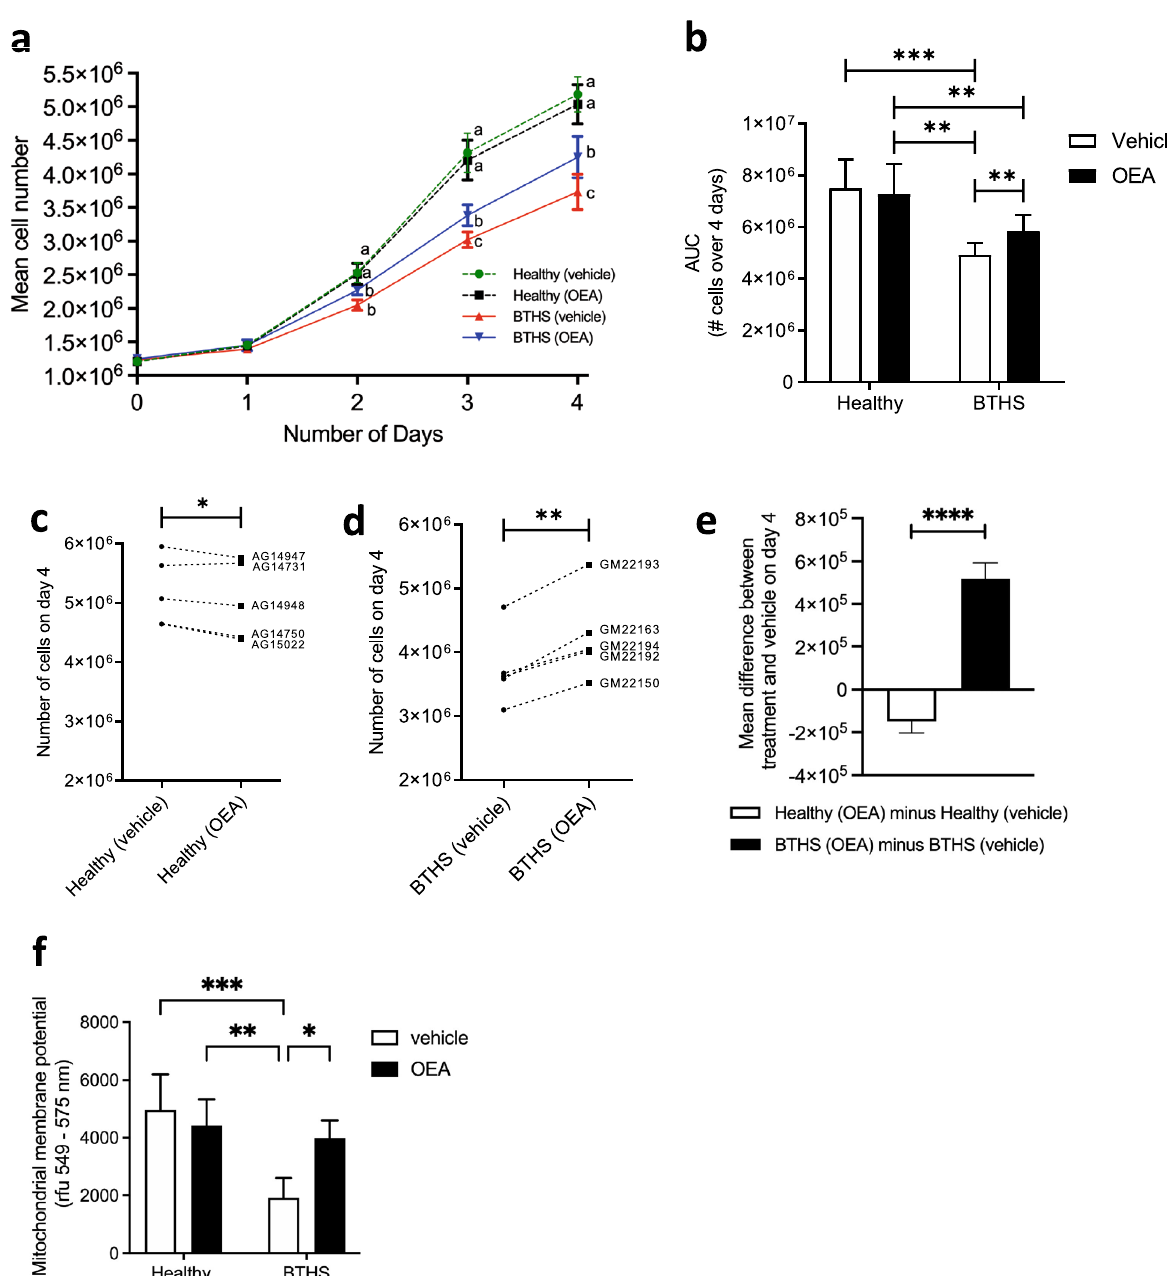
Figure 1. BTHS lymphoblasts exhibit impaired growth that is partially rescued by OEA treatment. Mean daily cell counts are shown from cultures of five healthy and five BTHS lymphoblast lines treated with either vehicle control (0.1% (v/v) ethanol) or OEA [1 µM] for 4 days ( a ), with accompanying area-under-the-curve analysis ( b ). The individual cell line responses to 1 µM OEA treatment are represented as cell counts on day 4 (vehicle versus OEA) for each of the five healthy ( c ) and five BTHS ( d ) lines. A comparison of the relative effect of treatment in healthy versus BTHS lines on mean cell number is also shown ( e ). Effects of OEA on mitochondrial membrane potential in all cell lines were measured ( f ). Data are means ± S.E.M; n = 5. abc Groups with different letters are significantly different at the same timepoint, P < 0.05. *P < 0.05, **P < 0.01, ***P < 0.001, ****P < fewer cells than their vehicle-treated controls, while BTHS lines treated with OEA had ~ 5 × 10 5 more cells than their vehicle-treated controls, and the difference between the responses of healthy and BTHS lines was highly statistically significant. Mitochondrial membrane potentials were analyzed as a measure of mitochondrial func- tion after 4 days of cell treatment with OEA or vehicle, and found to be significantly lower in vehicle-treated BTHS lymphoblasts compared to healthy controls treated either with vehicle or OEA. However, this measure was significantly restored in BTHS cells by OEA (Fig. 1f), suggesting that better mitochondrial function may contribute to the growth benefit of OEA in BTHS lymphoblasts.